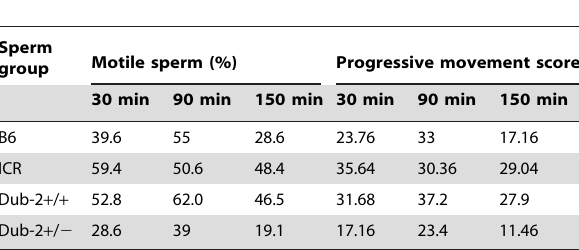
Table 4. Motility and progressive movement of mouse spermatozoa.